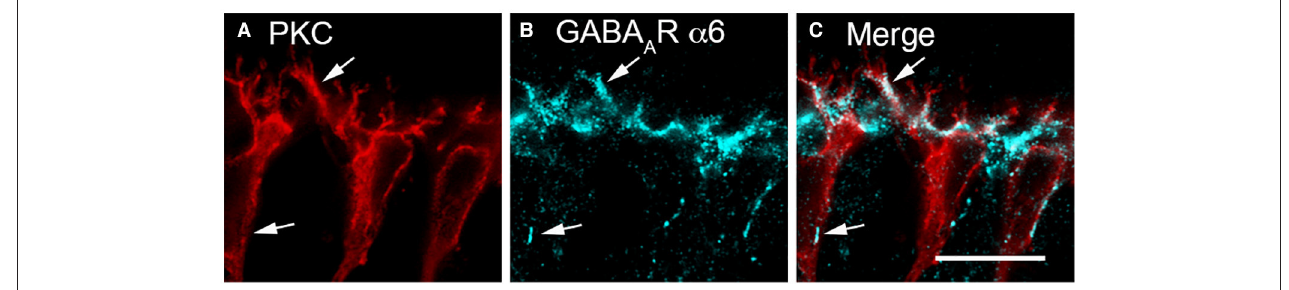
FIGURE 3 | GABA A R α 6 subunit immunolabeling occurred in bipolar cell dendrites. (A–C) Rod bipolar cells bear α 6 immunoreactivity on their dendrites. (A) PKC α antibodies identify rod bipolar cells (red). (B) α 6 immunolabeling (blue) occurs in patches along the bipolar cell dendrites (arrows) in the OPL and in the cell body membrane (arrows). (C) Merged image demonstrates co-localization of α 6 and PKC α immunoreactivities in the dendrites of rod bipolar cells (arrows) and to a lesser degree on their somata (arrows). Single optical section (A–C) . Scale bar, 10 µ m. (Modified from Hirano et al., 2016b).